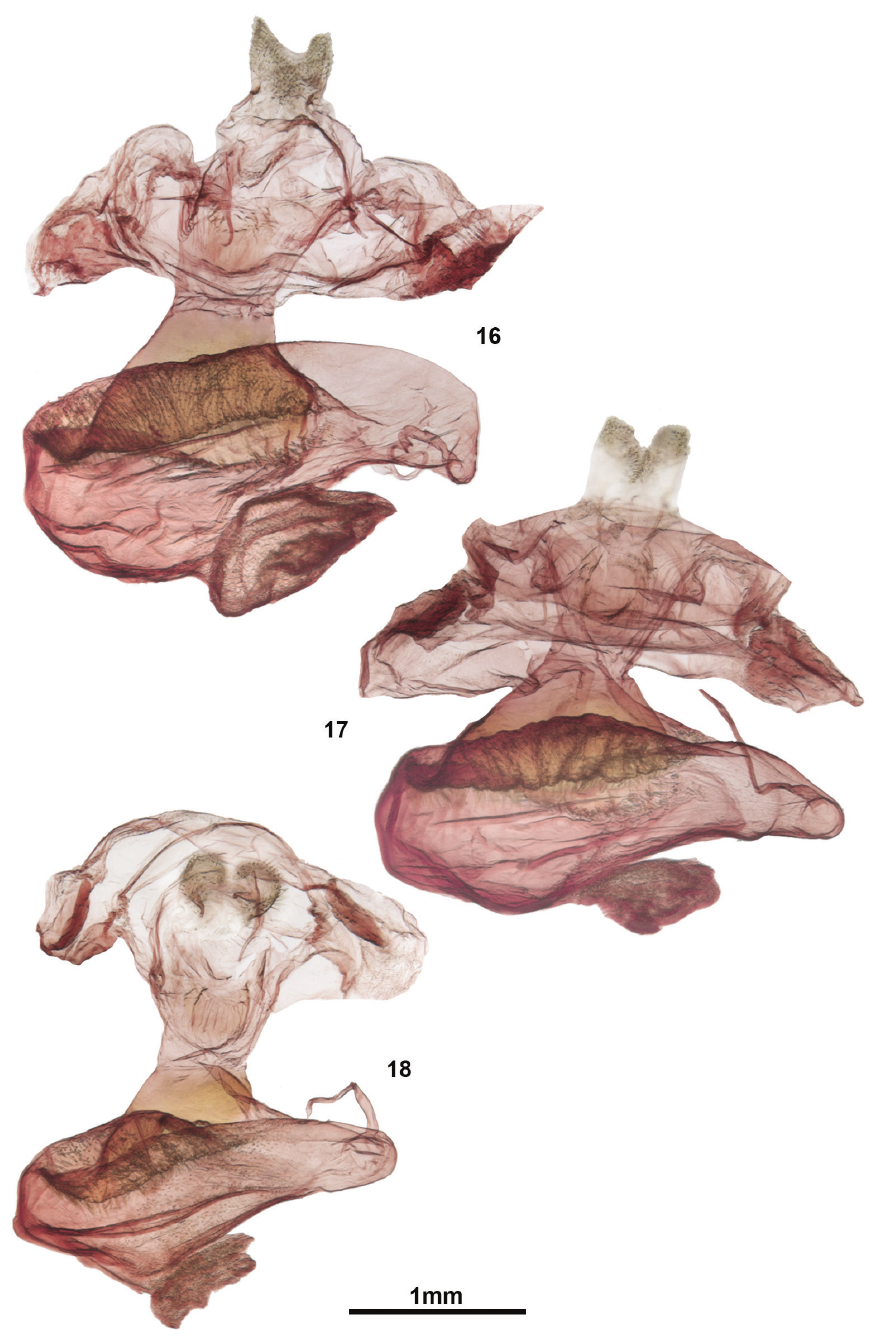
Figures 16–18. Clemensia female genitalia. 16 C. umbrata MB, Spruce Woods, CNC gen. prep. #14772 17 C. albata ON, Backus Woods, CNC gen. prep. #14773 18 C. ochreata FLA, Dunedin, CNC gen. prep.